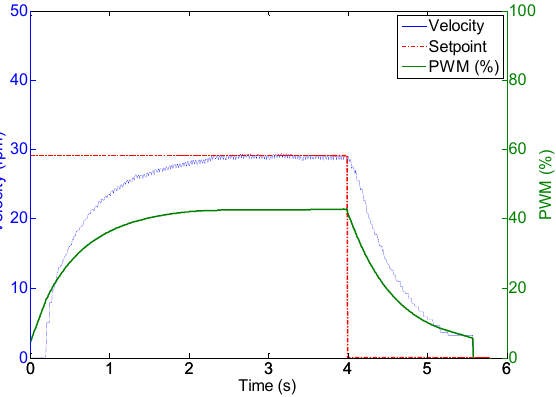
Figure 22. Wheel 1. Evolution of wheel velocity and applied motor PWM for a target velocity of 44 rpm.